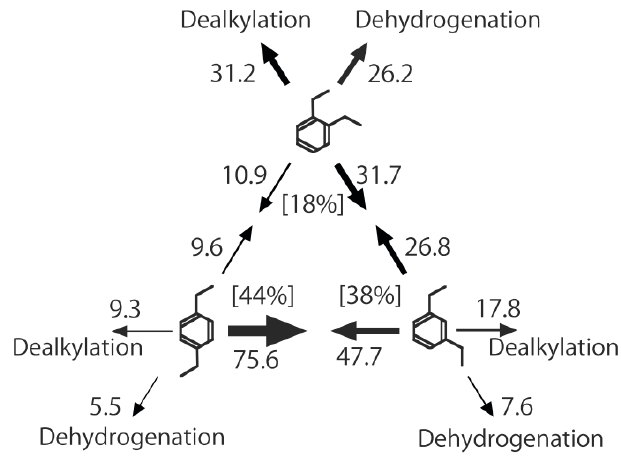
Figure 26. Isomerization of diethylbenzenes over (H the selectivity values (in %) at 400 °C, 4 h after the reaction was initiated. The other conditions are the same as those described in the caption to Figure 25. The thickness of each arrow is proportional to the corresponding selectivity. The equilibrium compositions of diethylbenzenes in the vapor phase at 400 °C are shown in